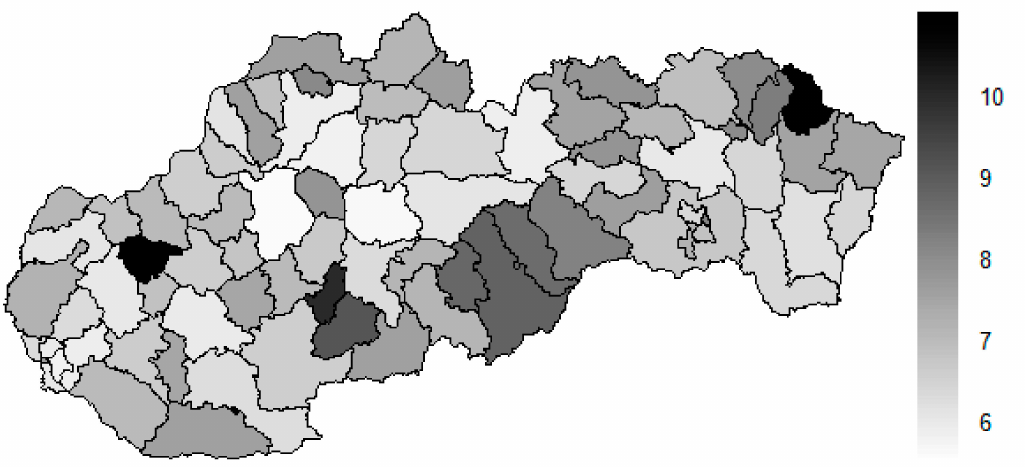
Figure 21. Preventable mortality similarity map of the districts for the female sex in the whole explored period. Source: own elaboration by the